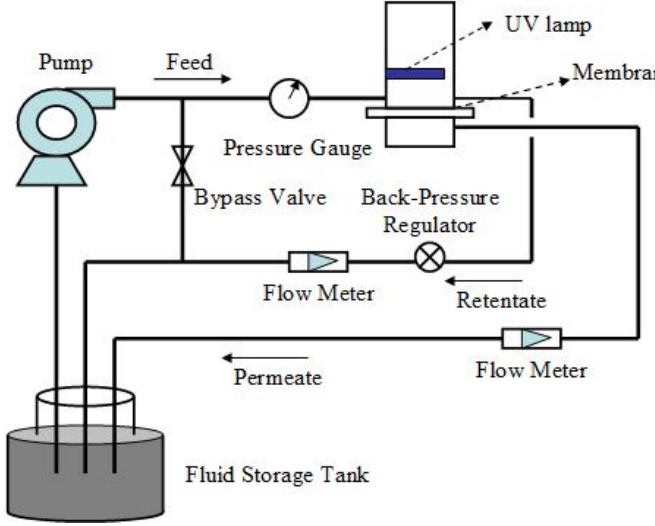
Figure 1. Schematic diagram of the cross-flow experiment.